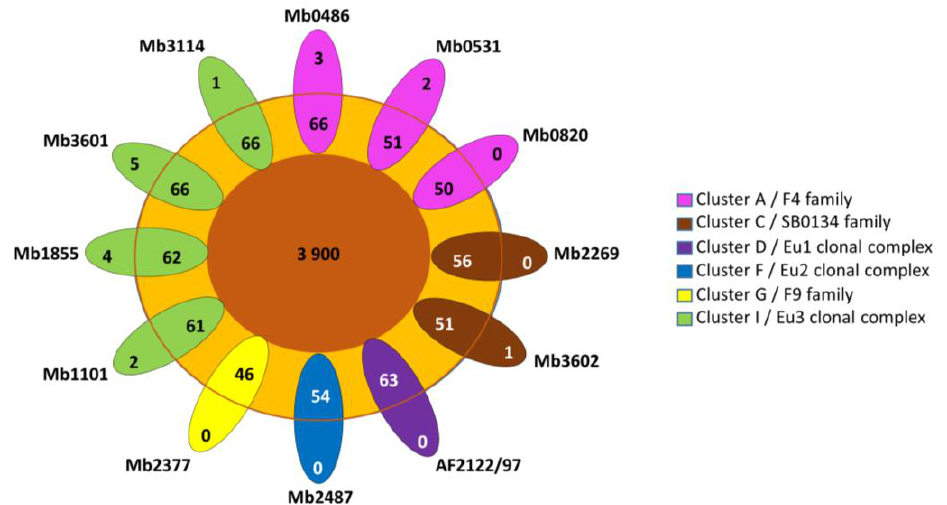
Figure 2. The gene distribution of pangenome. Flower plot showing in the center, genes present in all strains (core-genes), genes present in some strains (shell genes) in the annulus, and strain-specific genes of the 12 M. bovis complete genomes in the petals (cloud genes). Genomes are grouped in 6 previously described clusters